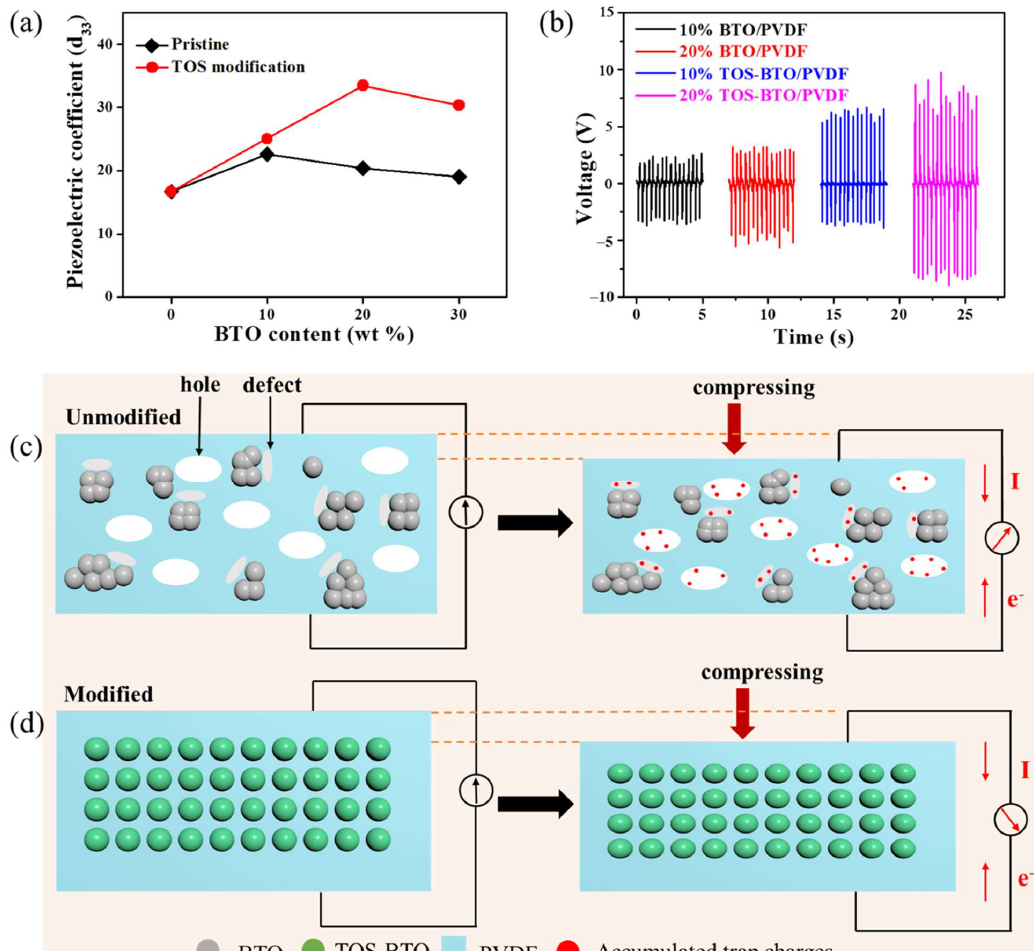
Figure 6. ( a ) Piezoelectric coefficient of PVDF-based composite films with various BTO or TOS-BTO nanoparticle contents. ( b ) Output voltages of PVDF-based composite films with various BTO or TOS-BTO nanoparticle contents. Schematic diagram of piezoelectric properties of the nanocomposite. ( c ) BTO/PVDF composite, ( d ) TOS-BTO/PVDF nanocomposite.